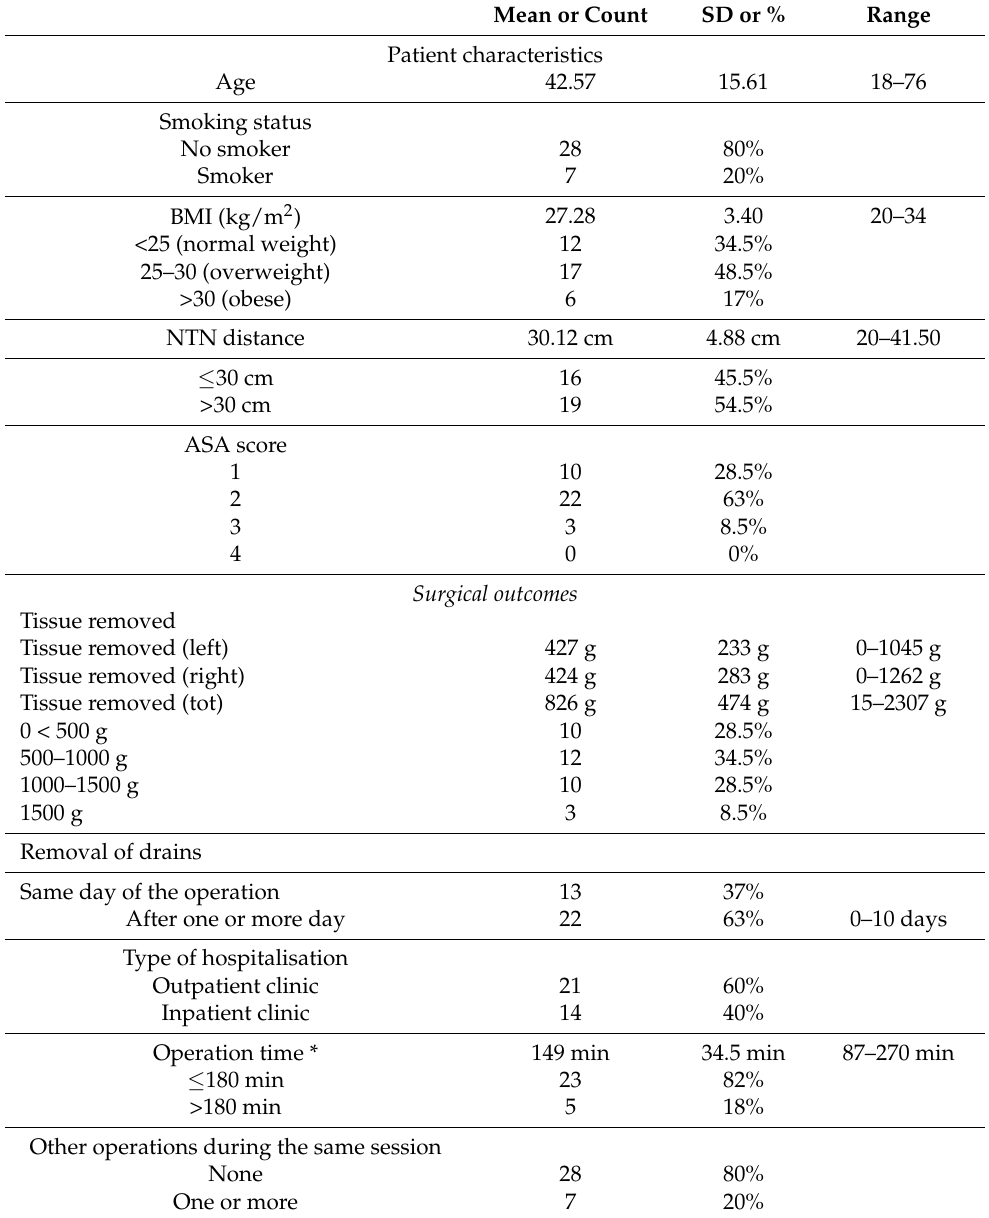
Table 1. Patients’ characteristics and surgical outcomes ( N = 35).